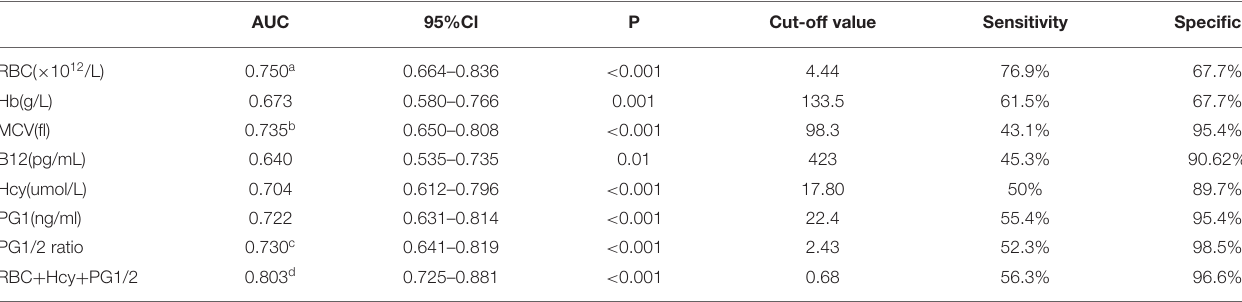
AUC Cut-off value